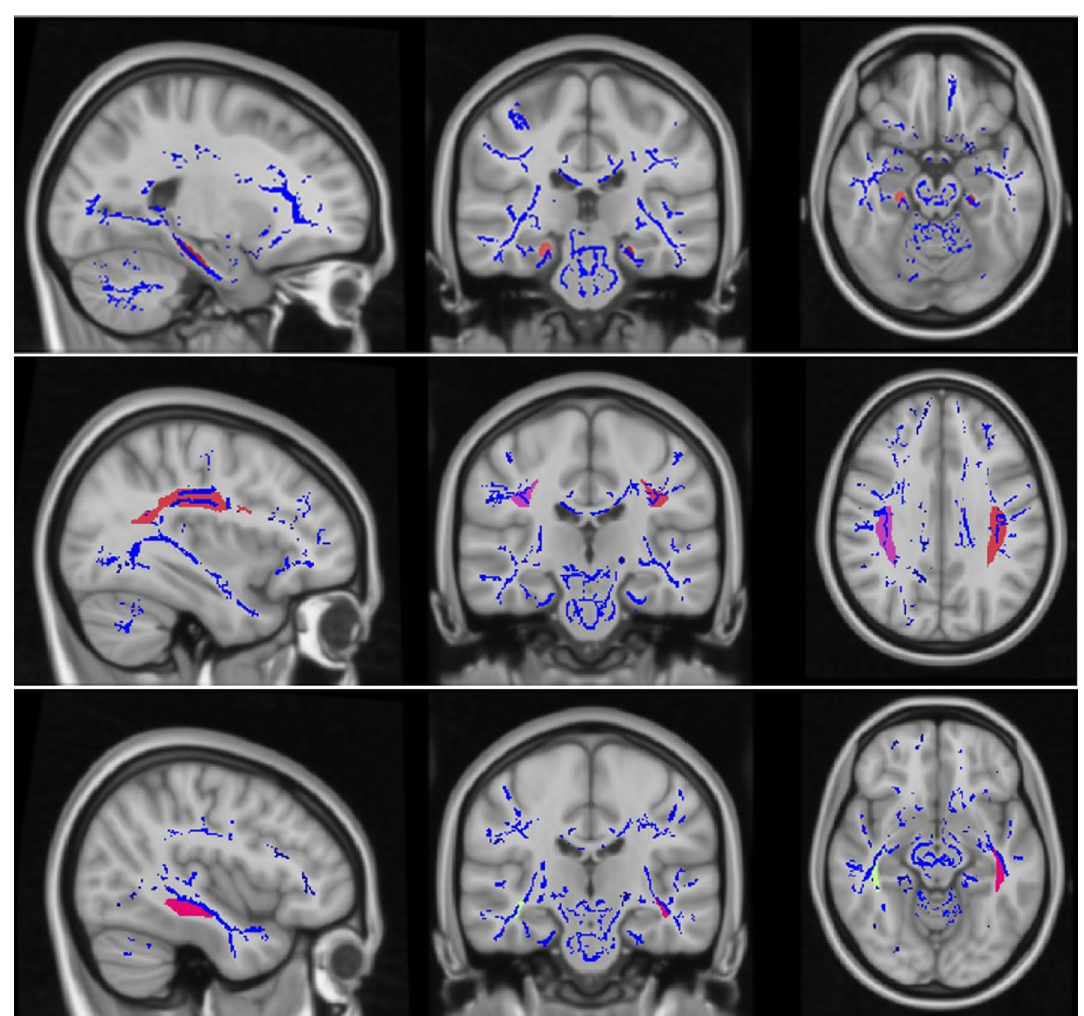
Fig. 9 Association fibers; hippocampus, sagittal stratum, superior longitudinal fasciculus displayed from top to bottom rows, respectively, showing statistically significant ( p value < 0.001) higher mean FA value in ASD group compared to TDC group displayed in